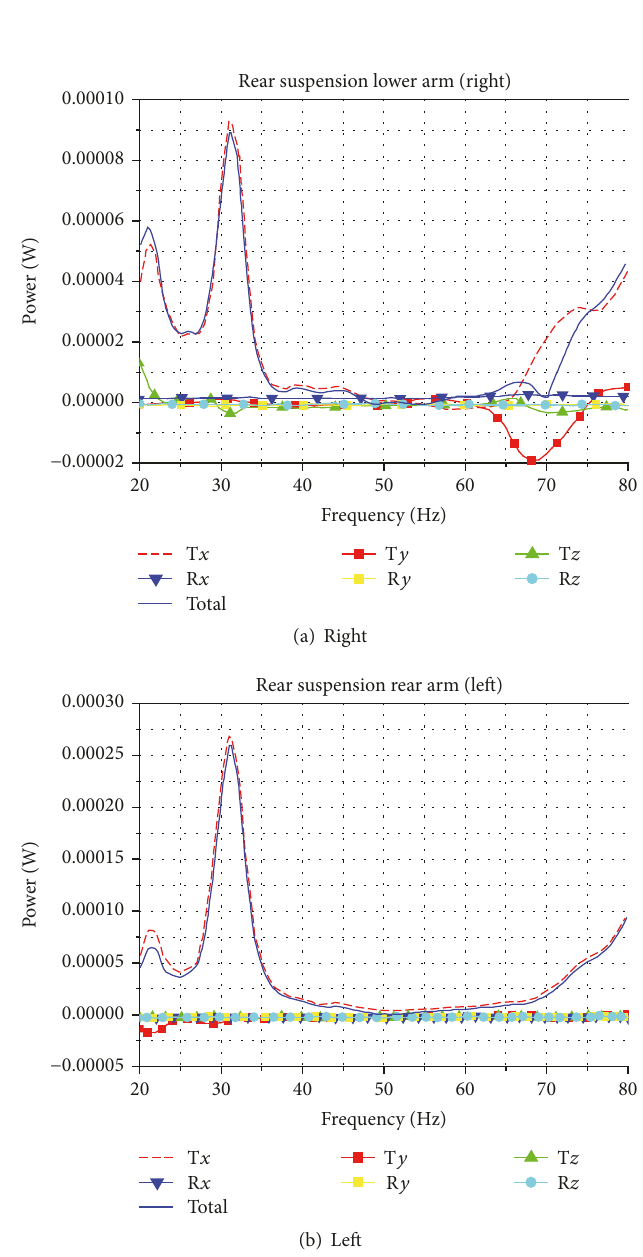
Figure 15: Power of rear suspension lower arm in 6 directions.